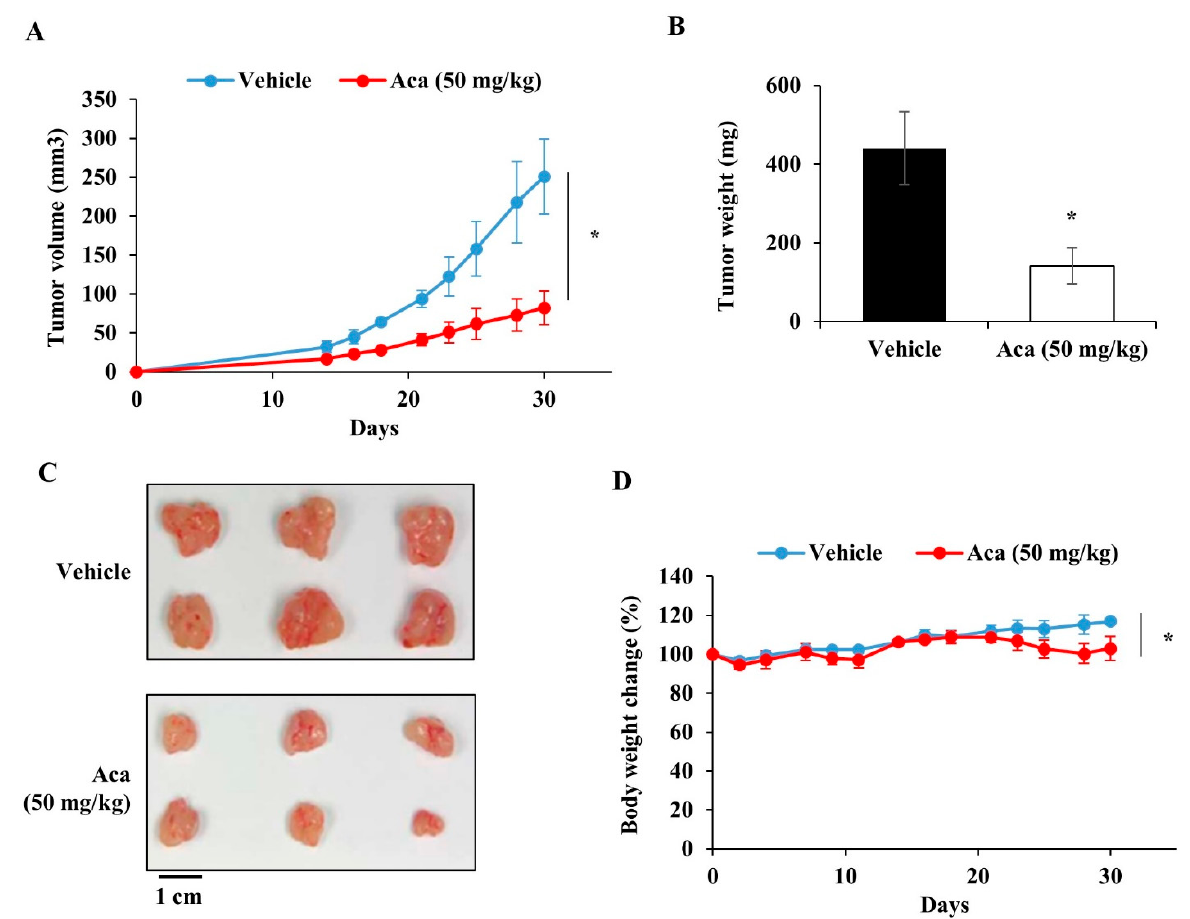
Figure 7. Acacetin inhibits the growth of DU145 human prostate cancer cells in a nude mouse xenograft model. ( A ) Quan- tification of the tumor volumes in each mouse ( n = 6 per group) on day 30. ( B ) Quantification of the tumor weight of tumor from each mouse ( n = 6 per group) on day 30. ( C ) Representative image of tumor tissues. ( D ) Evaluation of the body weight for each mouse ( n = 6 per group). The data represent the means ± s.d.; comparisons were performed with t-tests; * p < 0.05.